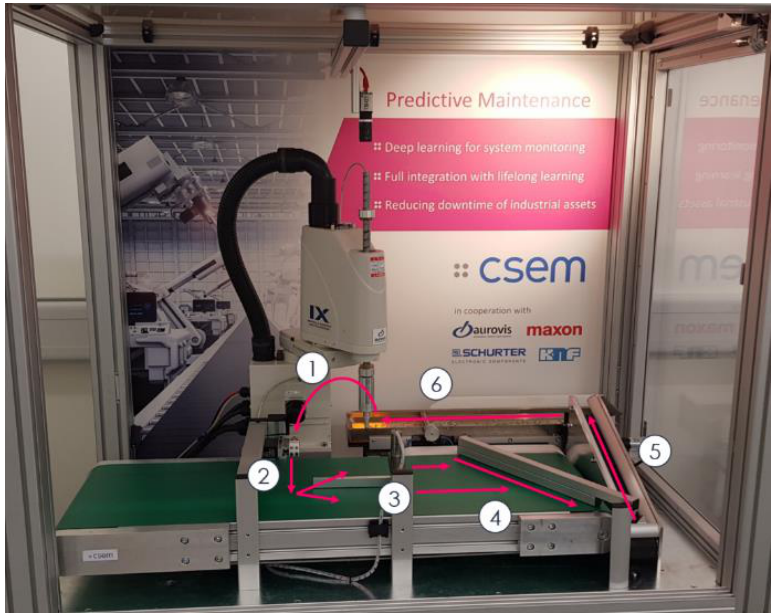
Figure 1. Equipment: 4-axis SCARA robot picking up electrical fuses with a vacuum gripper, from a feeder to a fuse-test-bench for large-scale quality control.